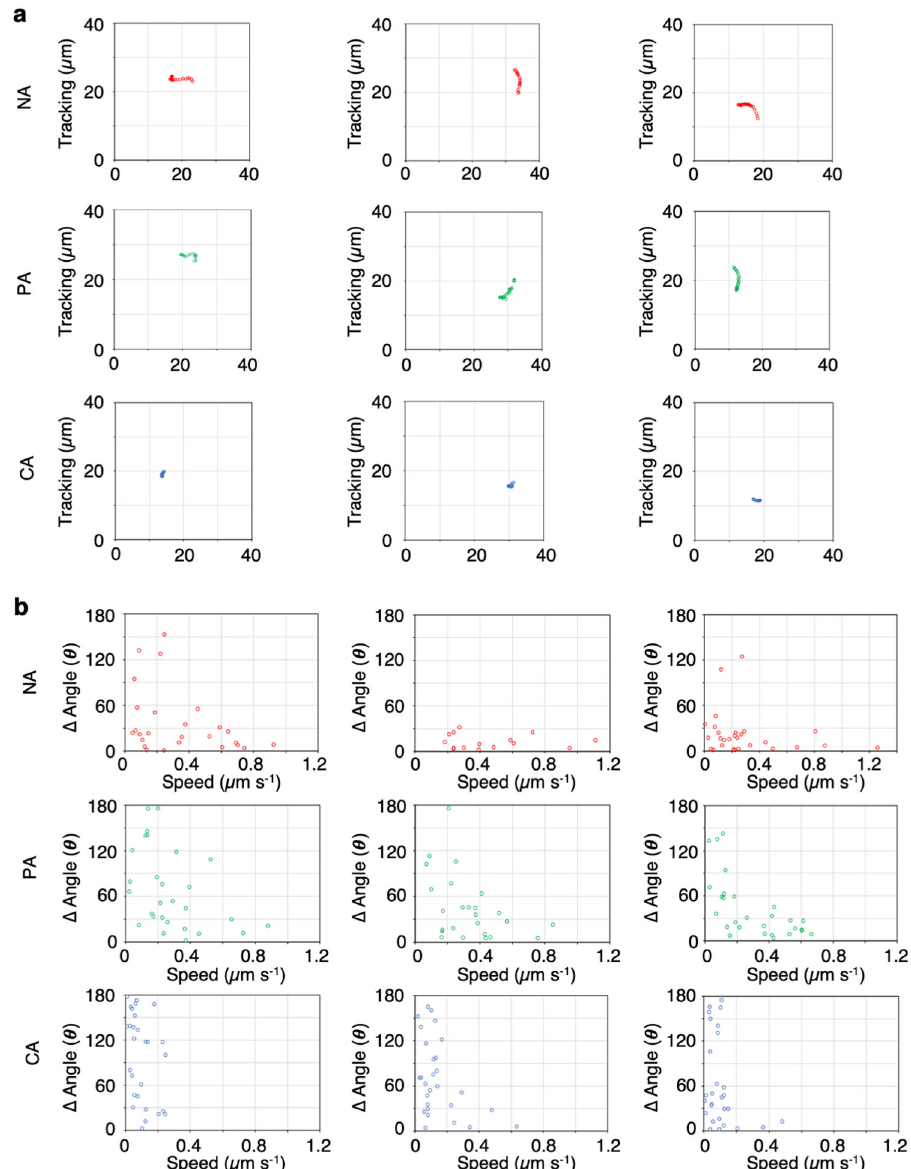
Fig. 8 Different patterns of mitochondrial movement depend on their association with chloroplasts. a , b Representative trajectories ( a ) and scatter plot of speed and angle changes ( b ) of three mitochondrial movements were classi fi ed as no association, NA (upper panels); partial association, PA (middle panels); and continuous association, CA (lower panels) with